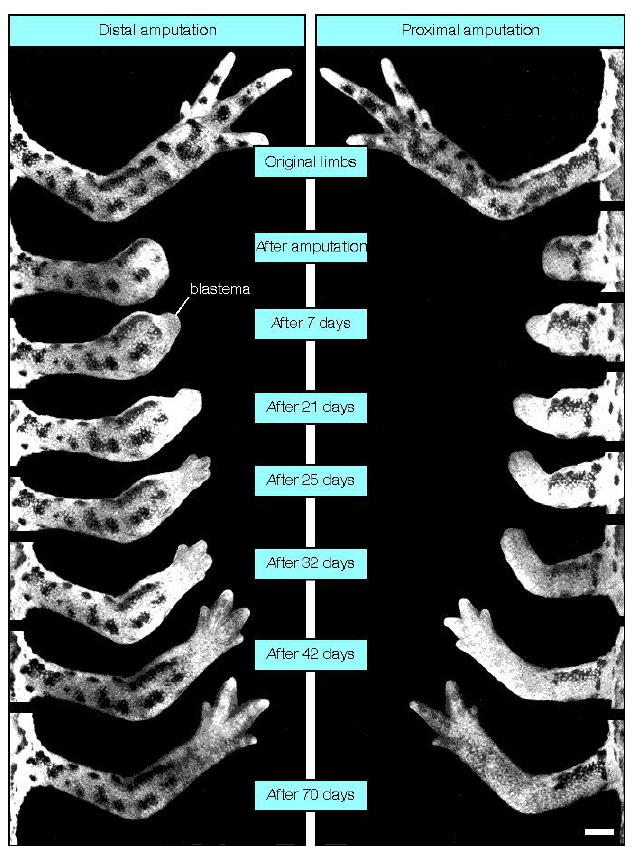
Figure 1. Regeneration of a salamander forelimb following distal amputation below the elbow (left) or proximal amputation through the humerus (right) (Adapted from